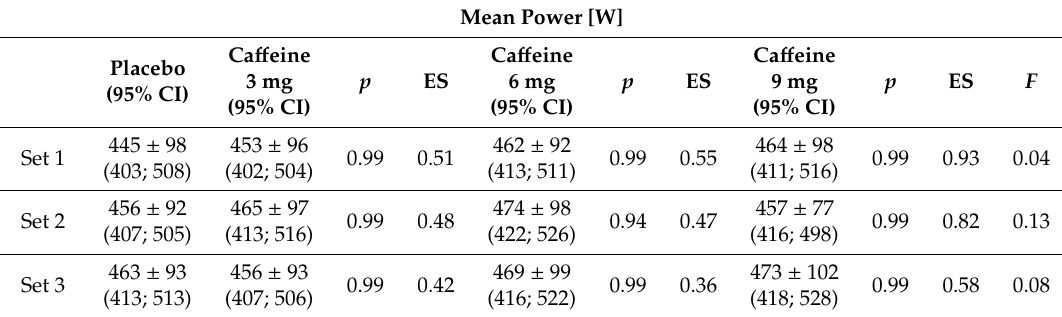
Table 1. Results of mean power output in three successive sets of the bench press exercise in the group that ingested di ff erent doses of ca ff eine, and the placebo group.